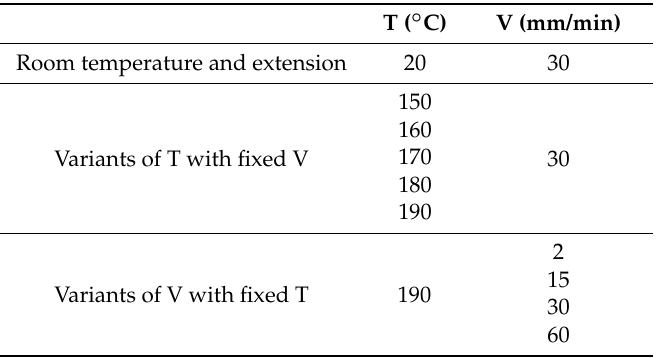
Table 2. The tensile test condition for a single yarn